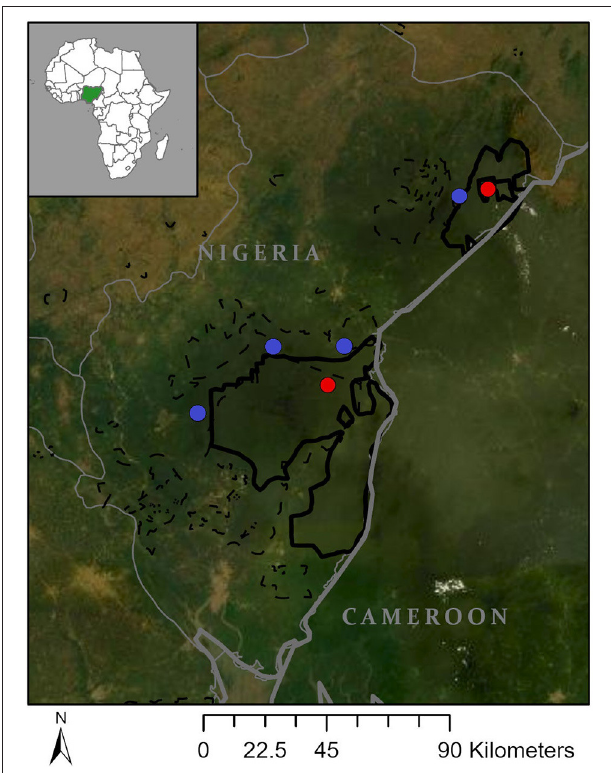
FIGURE 1 | Study communities. Map showing location of deep (red) and marginal (blue) forest communities relative to Cross River National Park (green) in